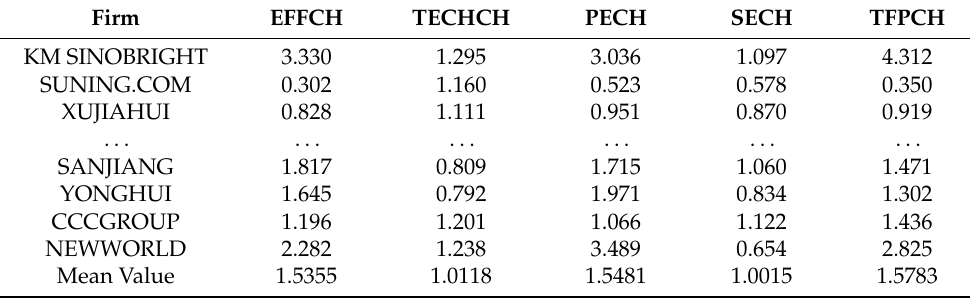
Table A8. MPI of 20 enterprises using the new retail model.